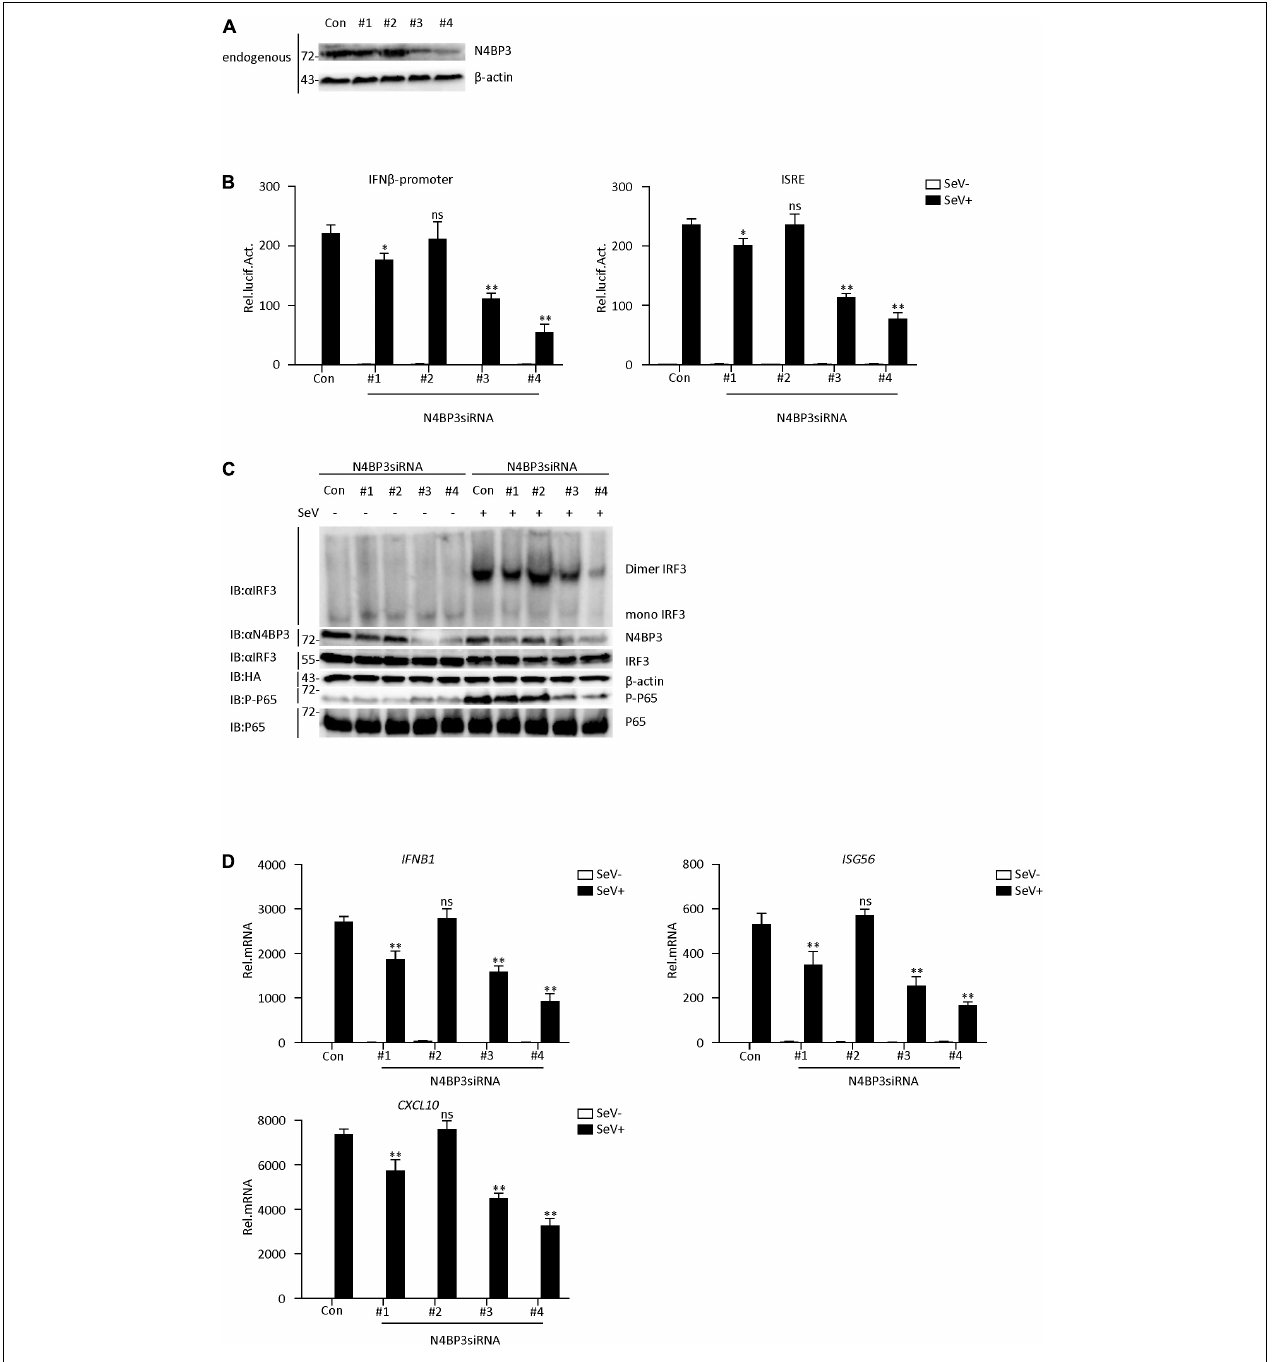
FIGURE 2 | Knockdown of N4BP3 inhibits RIG-I-MAVS antiviral signaling pathway. (A) The effect of N4BP3 shRNA plasmid on the expression of endogenous N4BP3. Co-transfected into 293T cells with control or N4BP3 shRNA plasmid and HA-Actb. Western blot analysis was performed with corresponding antibodies. (B) Knockdown of N4BP3 inhibits SeV-induced activation of IFN- β promoter and ISRE. 293T cells were transfected with the indicated N4BP3 shRNA (1.5 µ g) and reporter gene plasmids (0.05 µ g). After 12 h of transfection, the cells were left uninfected or infected with SeV for 12 h before luciferase assays were performed. The data table shown were presented as mean ± SD, n = 3, * P < 0.05, ** P < 0.01. (C) Knockdown of N4BP3 inhibits SeV-induced IRF3 dimer formation and phosphorylation of P65. 293T cells were transfected with control siRNA plasmid or designated N4BP3 siRNA plasmid (4.0 µ g each). 12 h after transfection, the cells were left uninfected or infected with SeV for 12 h. IRF3 dimers or monomers were analyzed by Native PAGE for western blot analysis. (D) Under SeV induction, knocking down N4BP3 blocked the expression of IFNB1, ISG56, and CXCL10 at the mRNA level. Transfected 293T cells with the indicated shRNA plasmid. After 12 h of transfection, the cells were left uninfected or infected with SeV for 12 h and then subjected to qRT-PCR detection. The data table shown were presented as mean ± SD, n = 3, * P < 0.05, ** P < 0.01.